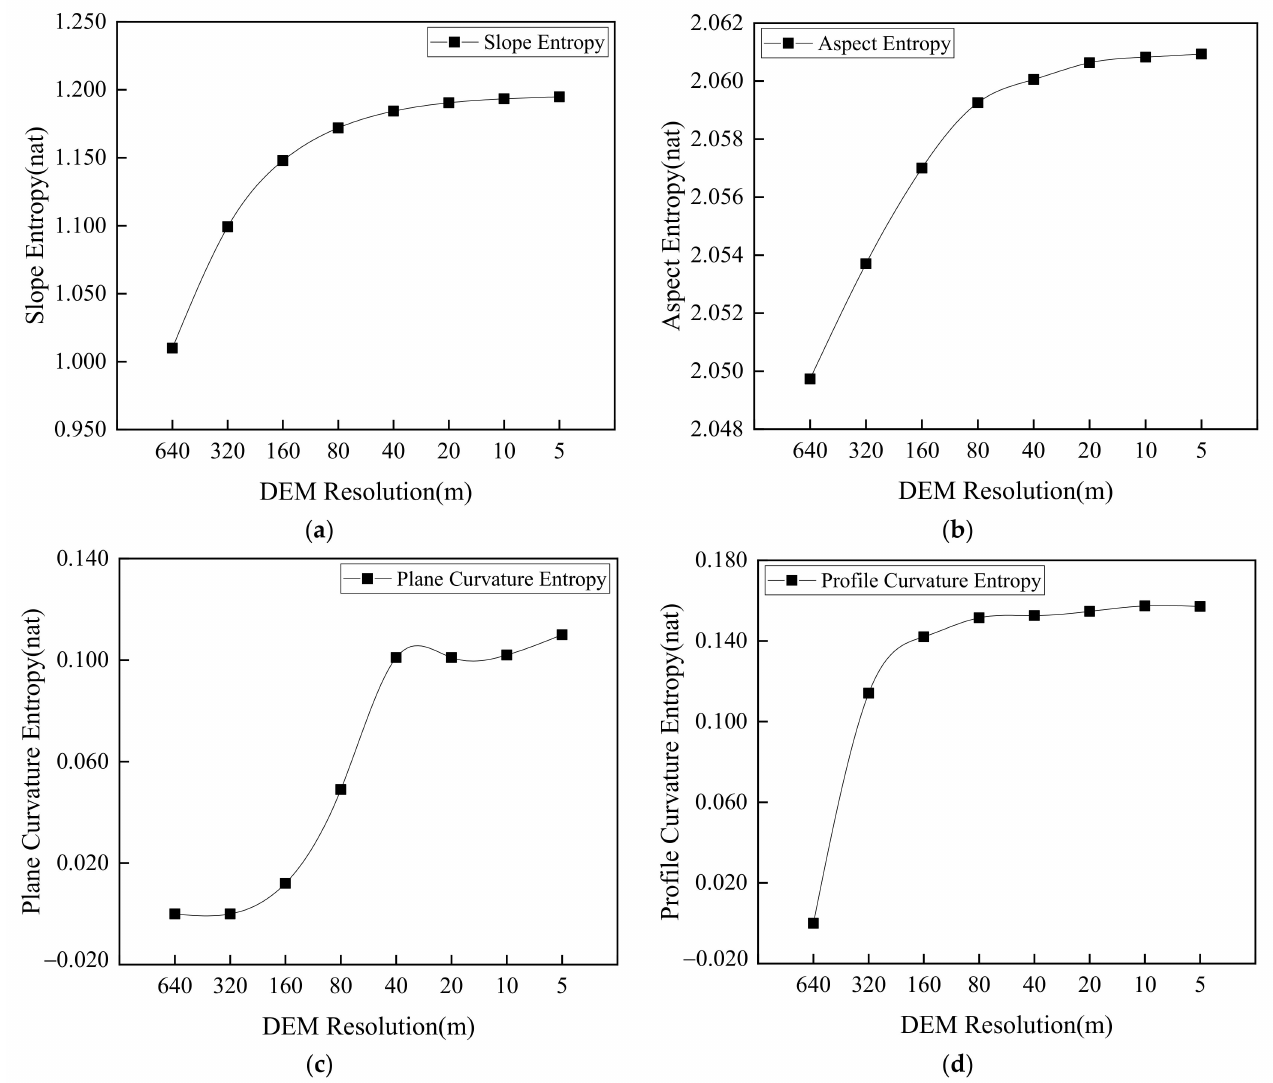
Figure 4. Graph of change of information entropy of terrain factor. ( a ) Slope entropy; ( b ) aspect entropy; ( c ) plane curvature entropy; ( d ) profile curvature